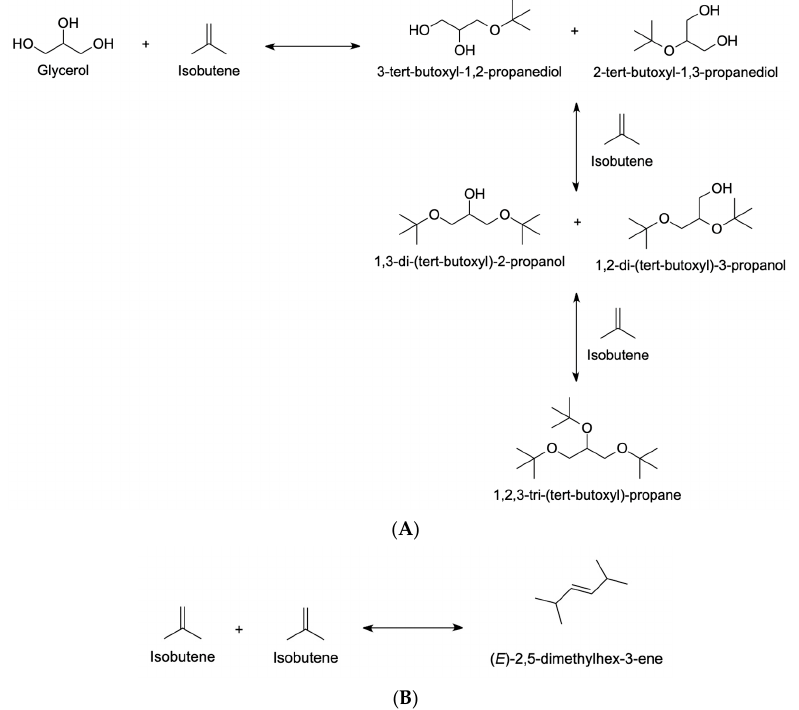
Figure 14. ( A ) Reaction mechanism of glycerol etherification with isobutene [103]; ( B ) Reaction mechanism of dimerization of isobutene [103].